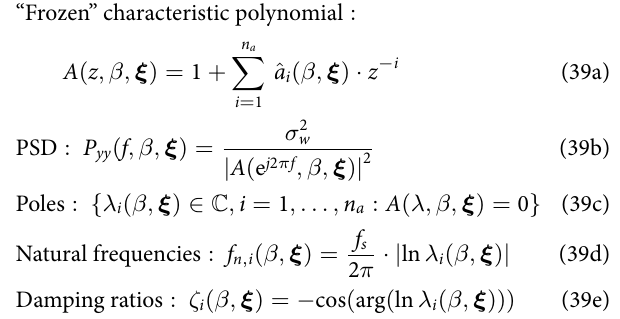
the dynamics is based on the “frozen” Power Spectral Density, natural frequencies and damping ratios, which are calculated by means of the following